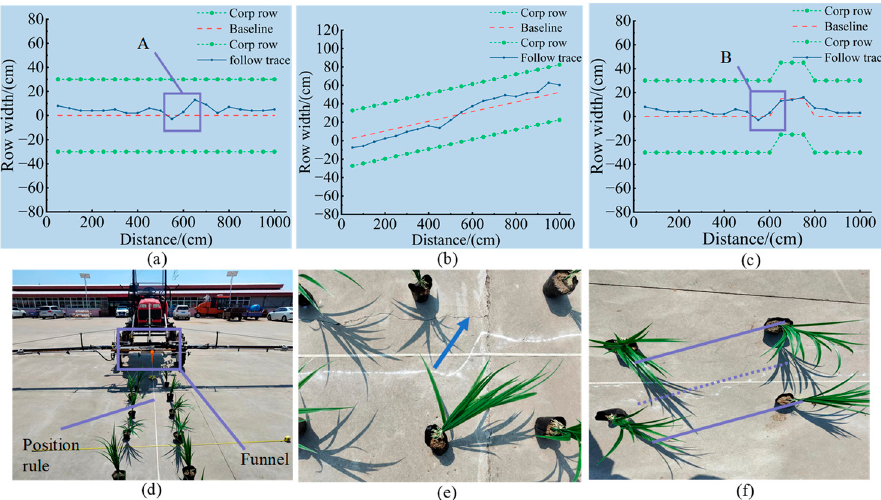
Figure 19. Row alignment test. ( a ) Parallel test; ( b ) Inclination test; ( c ) S-shaped test; ( d ) Testing layout; ( e ) Section A; ( f ) Section B.